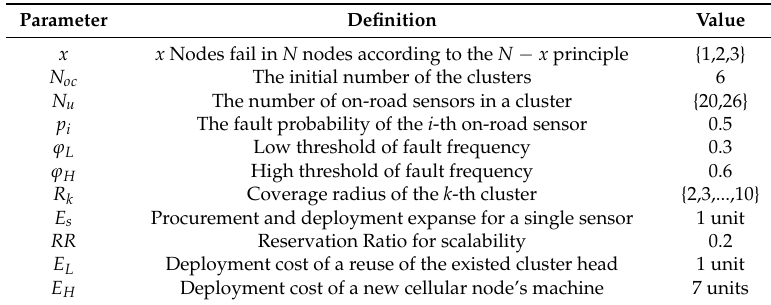
Table 2. Simulation